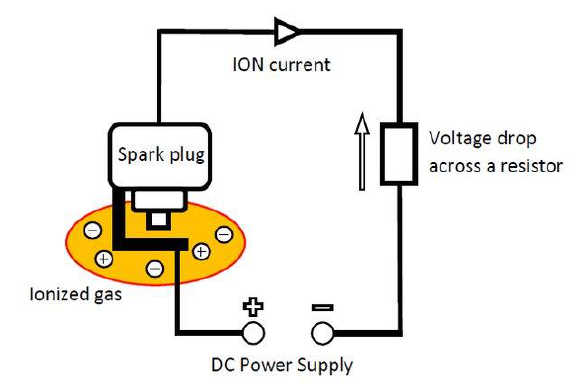
Fig. 3. Electric schematic of the measurement system [4]